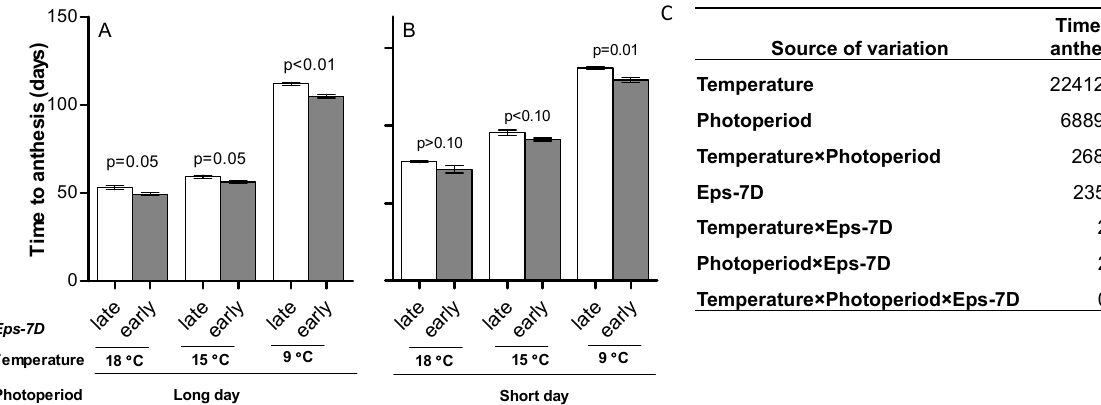
Figure 1. Duration of whole phase from seedling emergence to anthesis for the lines carrying Eps-7D - late (open bars) or - early (closed bars) on Ppd-D1a background under three growing temperatures under long ( A ) and short days ( B ). Error bars indicate the standard error of the means (SEMs) and the “ p ” values stand for the level of significance exclusively due to the action of the Eps-7D gene within each temperature and photoperiod condition. The output (mean squares) of the three-way ANOVA for time to anthesis (days) is included on the right ( C ). Significance level * p < 0.05; *** p < 0.001; NS = non-significant.